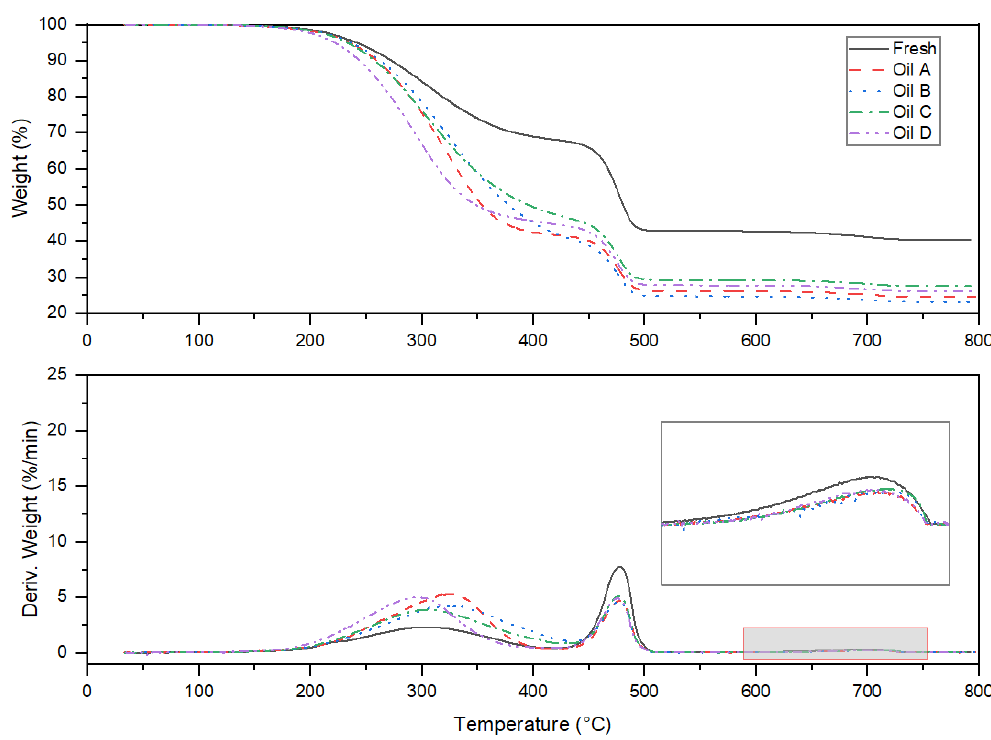
Figure 12. TGA (above) and DTGA (below) curves expressed as mass percentage and mass percentage over time, for fresh and 168 h aged EPDM.